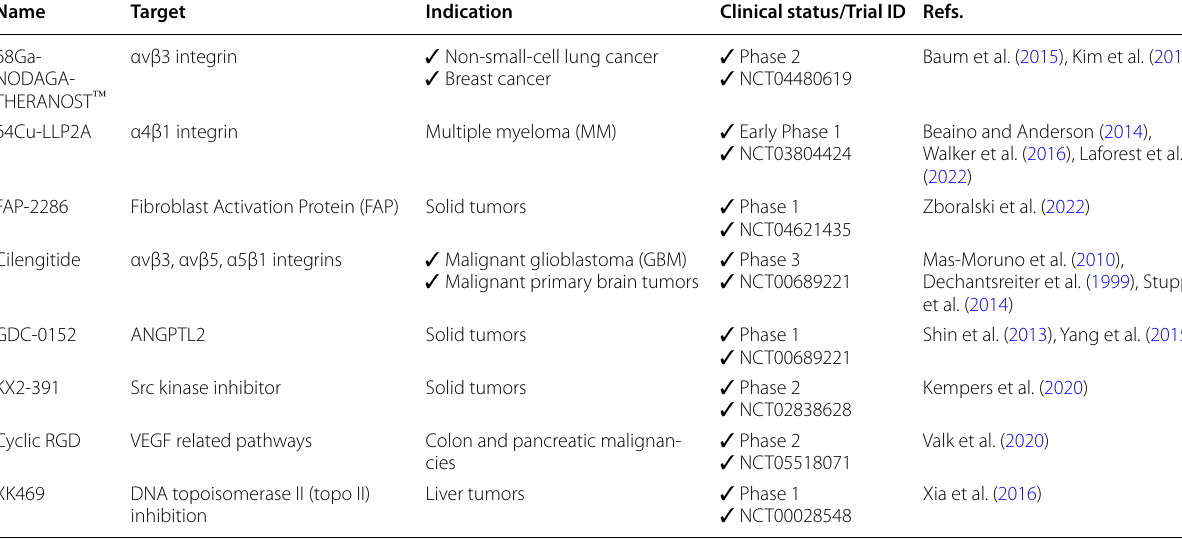
Table 2 Some key features of anticancer peptidomimetics that have entered the clinical